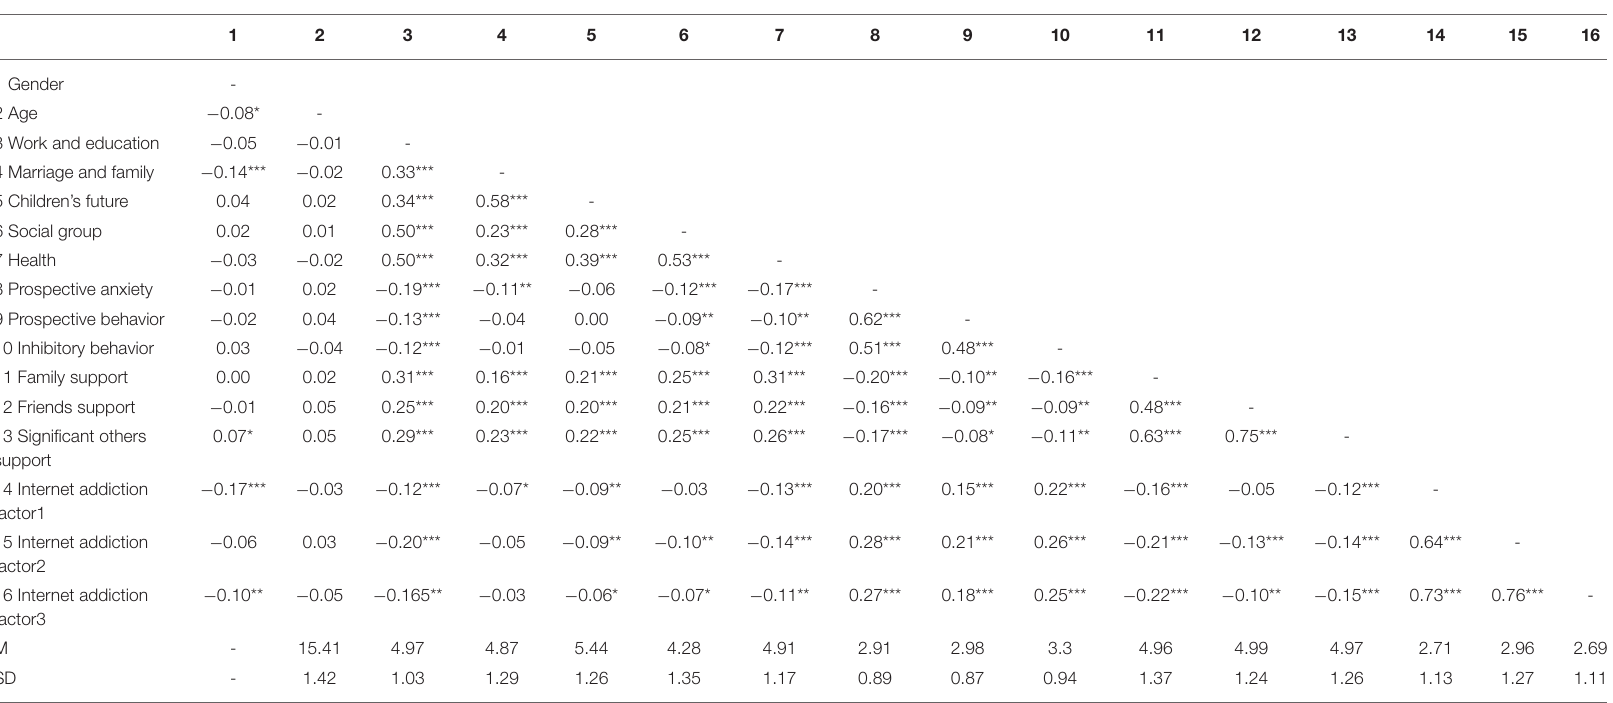
TABLE 1 | Descriptive statistics and correlations for all